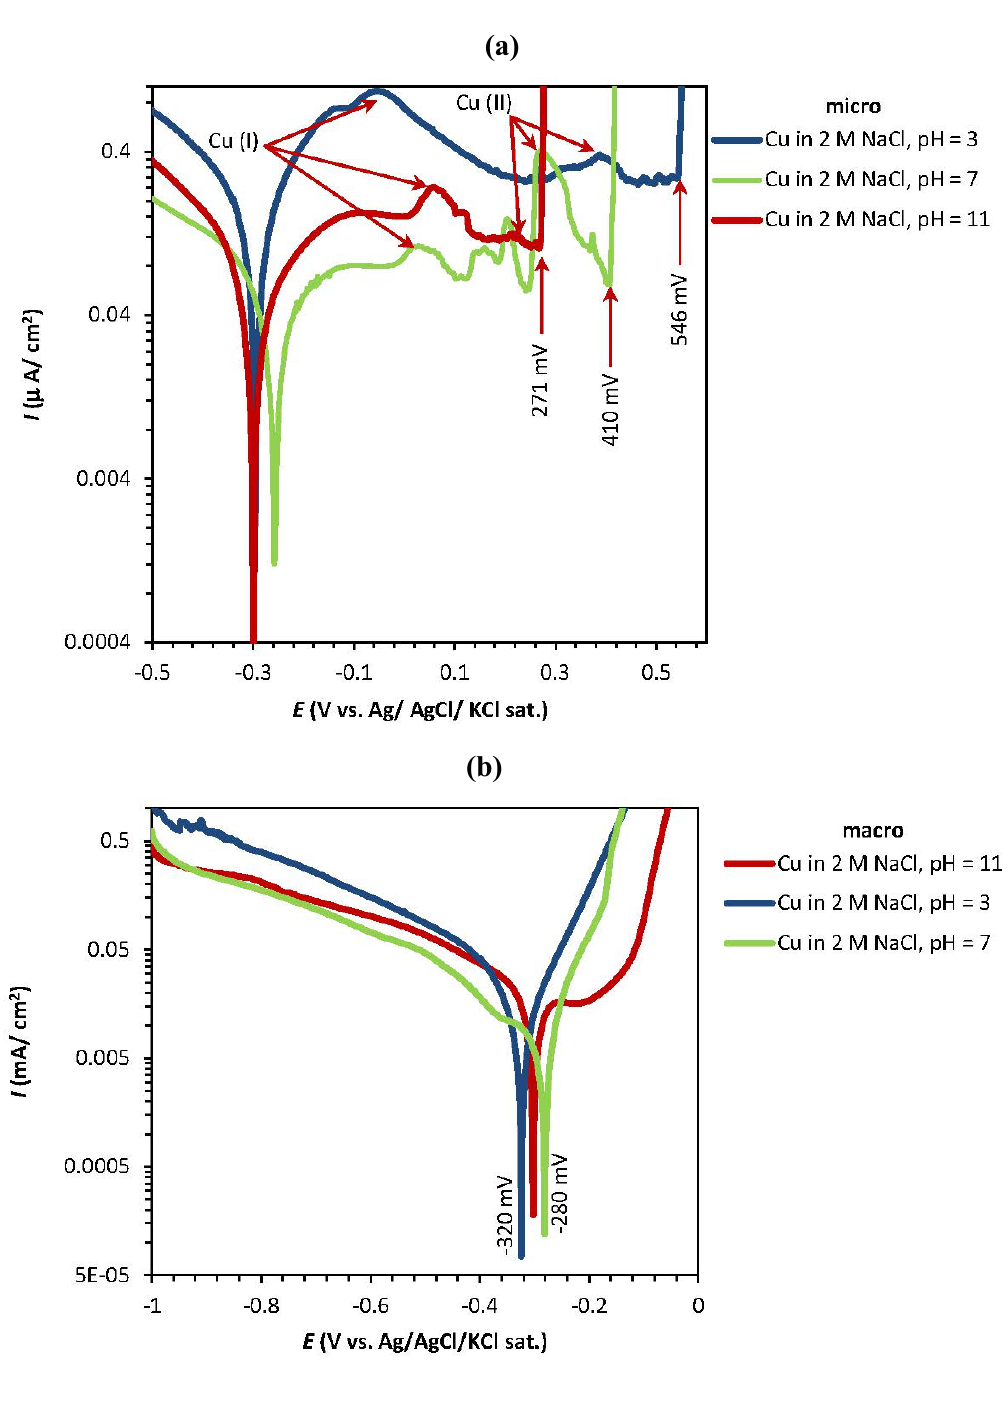
Figure 2. Potentiodynamic polarization curves of pure copper for various ( a , b ) pH values and ( c , d ) NaCl concentrations at the micro and macro scale. The tip diameter of the used microcapillary is ~100 μ